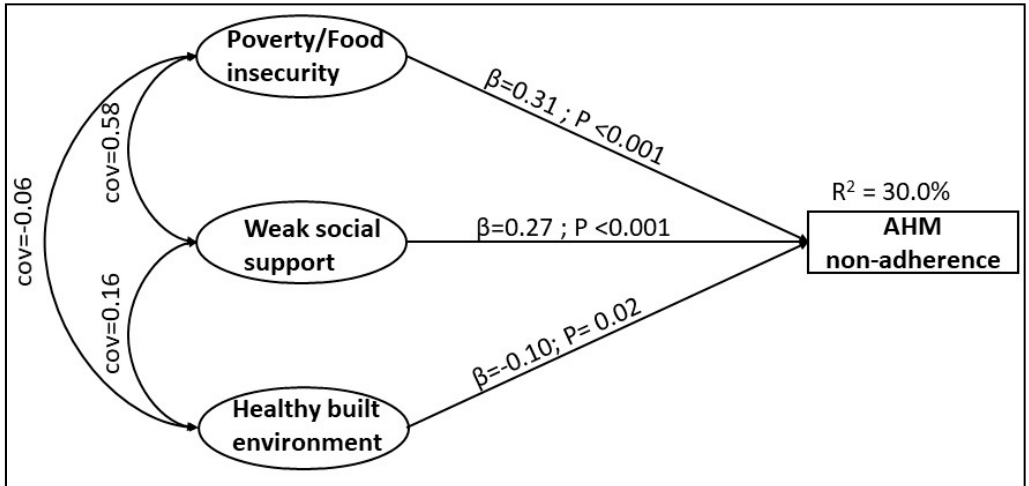
Figure 2. Relationships between social determinants of non-adherence and antihypertensive medication non-adherence. Indicators per construct. Poverty/food insecurity: percent below poverty line (%), uninsured (%), food stamp/SNAP recipient (%), and food insecurity (%). Weak social support: children in single-parent household (%), families with female household head (%), and residential segregation, non-white/white (%). Healthy built environment: population living within half a mile of a park (%), severe housing problems (%), and access to exercise opportunities (%).